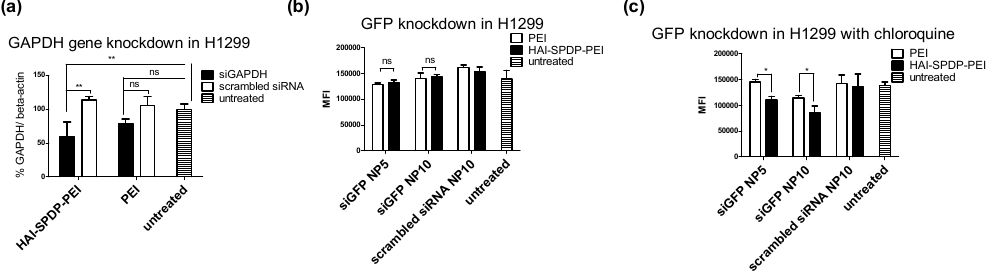
Figure 7. ( a ) H1299 were transfected with bPEI or HAI-SPDP-bPEI polyplexes formulated with 50 pmol of siRNA against GAPDH (siGAPDH) or scrambled siRNA at N/P = 5 for 24 h. The expression of GAPDH was determined by RT-PCR and normalized to the expression of β -actin. Untreated control represented 100% GAPDH/ β -actin. (Data points indicate mean ± SD, n = 3. No significance (ns), p > 0.05, ** p < 0.01); ( b ) H1299/eGFP cells were transfected with bPEI and HAI-SPDP-bPEI polyplexes for 48 h without chloroquine treatment; ( c ) H1299/eGFP cells, stably expressing eGFP, were transfected with bPEI or HAI-SPDP-bPEI polyplexes prepared with 50 pmol of siRNA against eGFP (siGFP) or scrambled siRNA at N/P = 5 and 10 for 48 h with chloroquine treatment. The MFIs of eGFP were quantified by flow cytometry. (Data points indicate mean ± SD, n = 3. ns, p > 0.05, * p < 0.05)